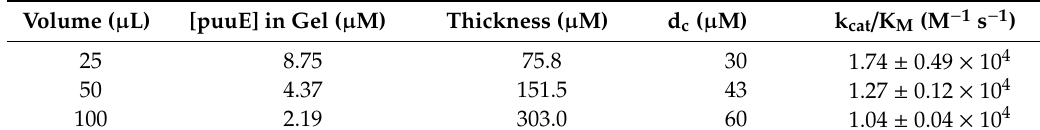
Table 2. Thickness and matrix critical thickness (d c ) of different sol-gel volumes containing 7.75 µg of puuE. Matrix thickness was calculated from encapsulation volume assuming 3.3 cm 2 as the base area of a parallelepiped; d c values were calculated applying Equations (3) and (4) and using catalytic parameters of free puuE listed in Table 1.